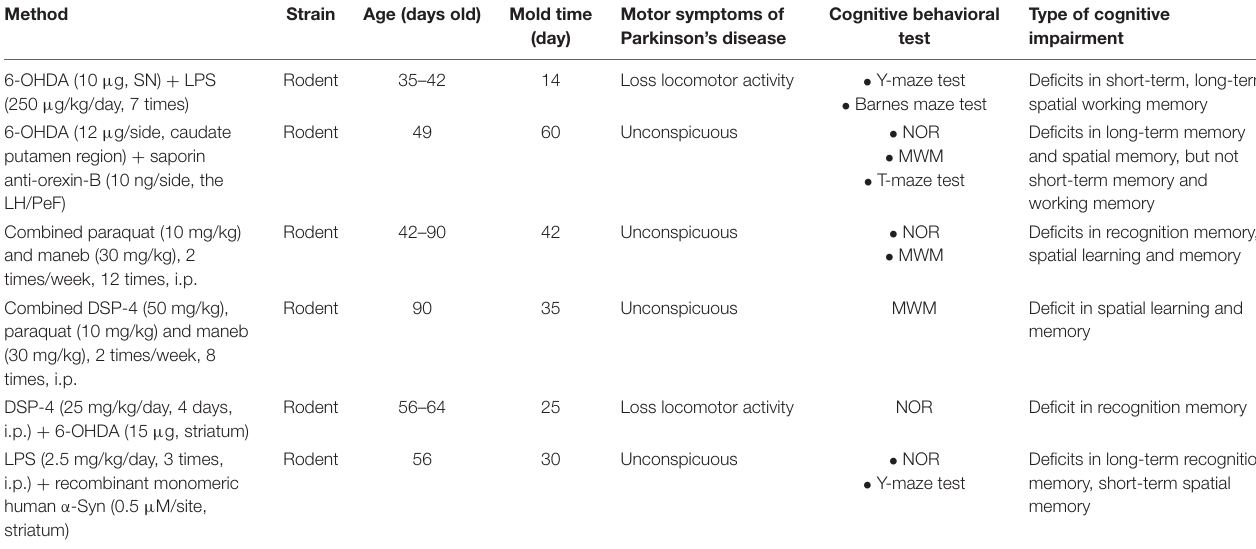
TABLE 6 | Methods of dual/multiple toxins induced